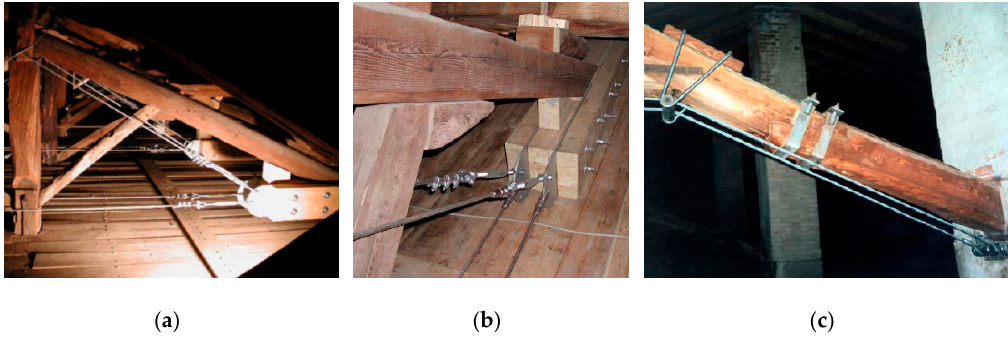
Figure 18. Reinforcement interventions using stainless steel wire ropes (design, Prof. L. Jurina): ( a ) and ( b ) Residence Masciadri in Arcene, Italy; ( c ) Residence Masciadri in Arcene, Italy